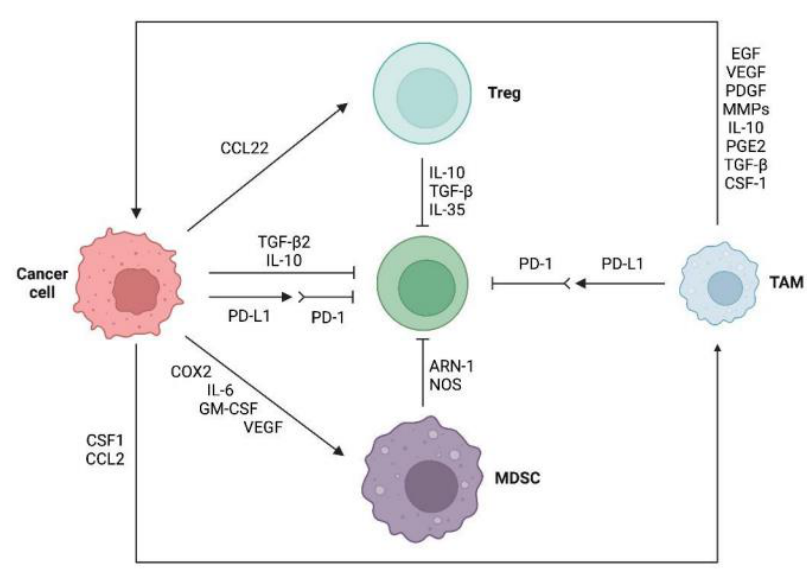
Figure 2. Immunosuppressive tumor microenvironment in anti-PD-1/PD-L1 therapy. TNBC cells can directly inhibit the activity of effector T cells by upregulating PD-L1 and releasing TGF- β 2 and IL-10. Additionally, immunosuppressive cells, including TAM, Tregs and MDSCs, are recruited to the tumor microenvironment, where they can inhibit the anti-tumor of T cells. TAM can also promote tumor cell proliferation by secreting EGF and PDGF, facilitates tumor invasion and metastasis by releasing pro-tumor cell metastasis factors such as MMPs, triggers immune escape of tumor cells by producing IL-10, PGE2, TGF- β and CSF-1, as well as contributes to tumor microvascular growth by expressing VEGF. Abbreviations: PD-1, Programmed cell death-1; PD-L1, Programmed cell death-ligand-1; CSF1, colony stimulating factor 1; CCL2, C-C motif ligand 2; CCL22, C-C motif ligand 22; TGF- β